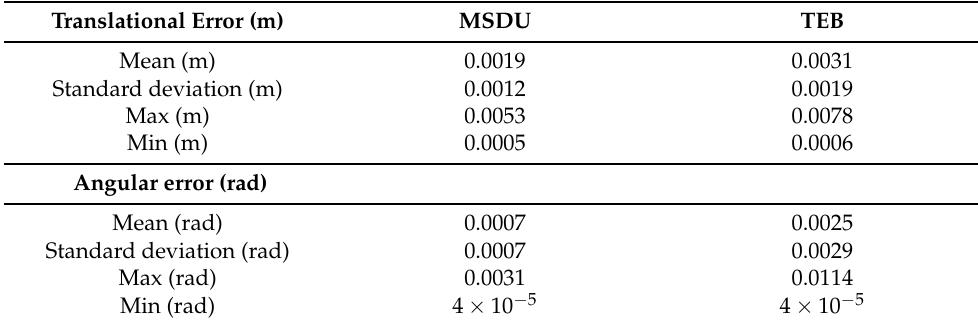
Table 3. Summary of performance of MSDU and TEB for long